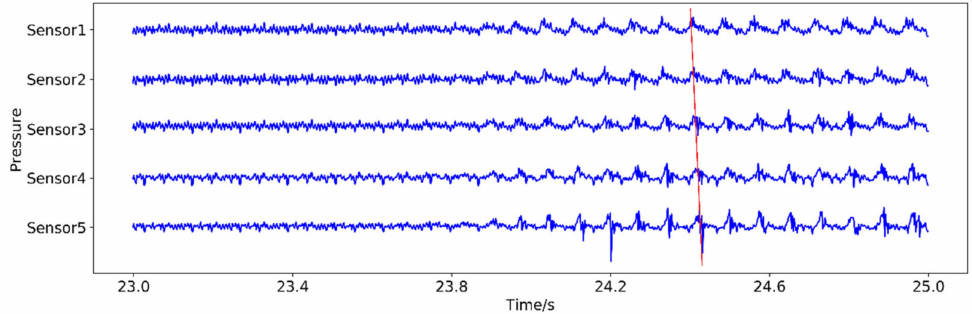
Figure 3. Pressure signals after resampling and